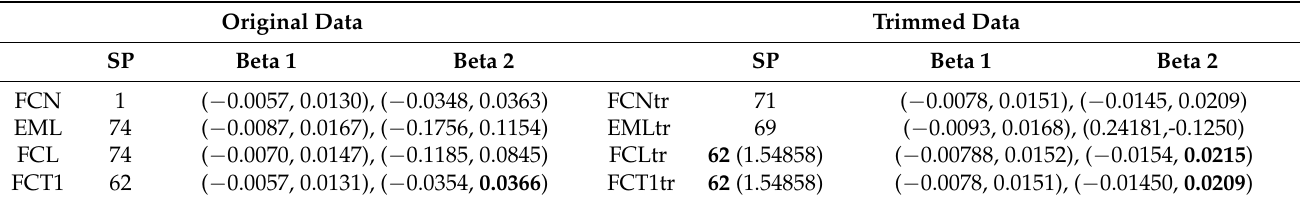
Table 3. Estimated models derived from the four methods with original and trimmed data.